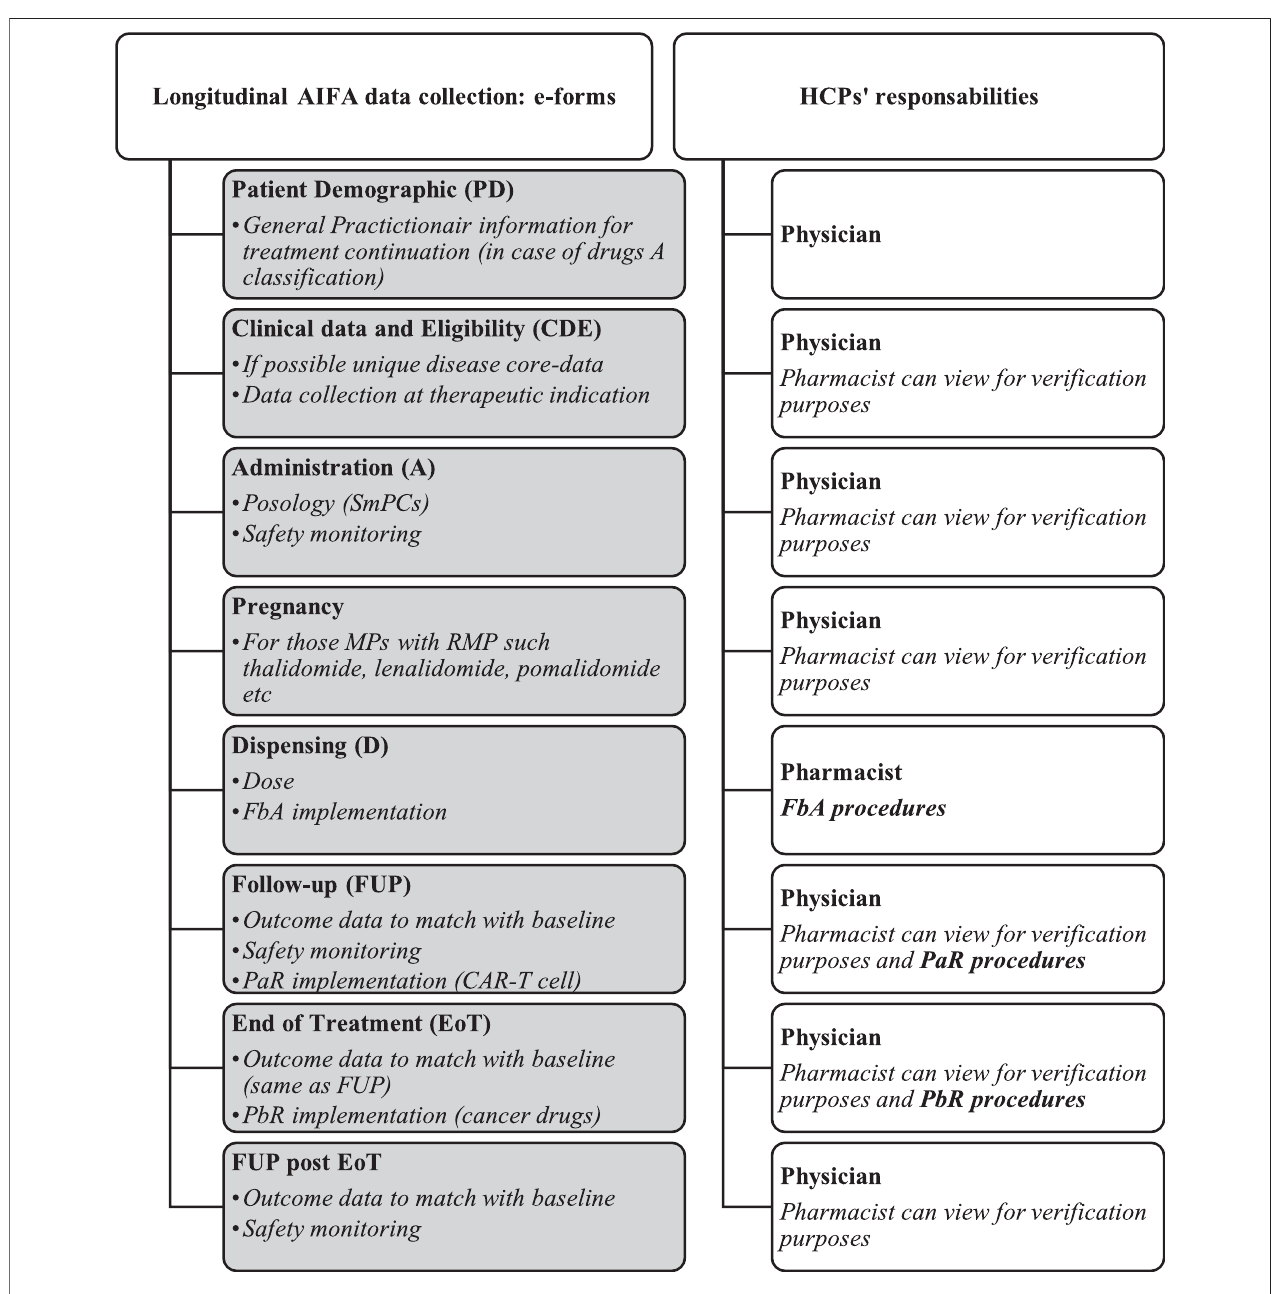
FIGURE 5 | Stakeholder responsibilities within AIFA longitudinal registries. FbA, fi nancial-based agreement; PaR, payment at result; PbR, payment by result.